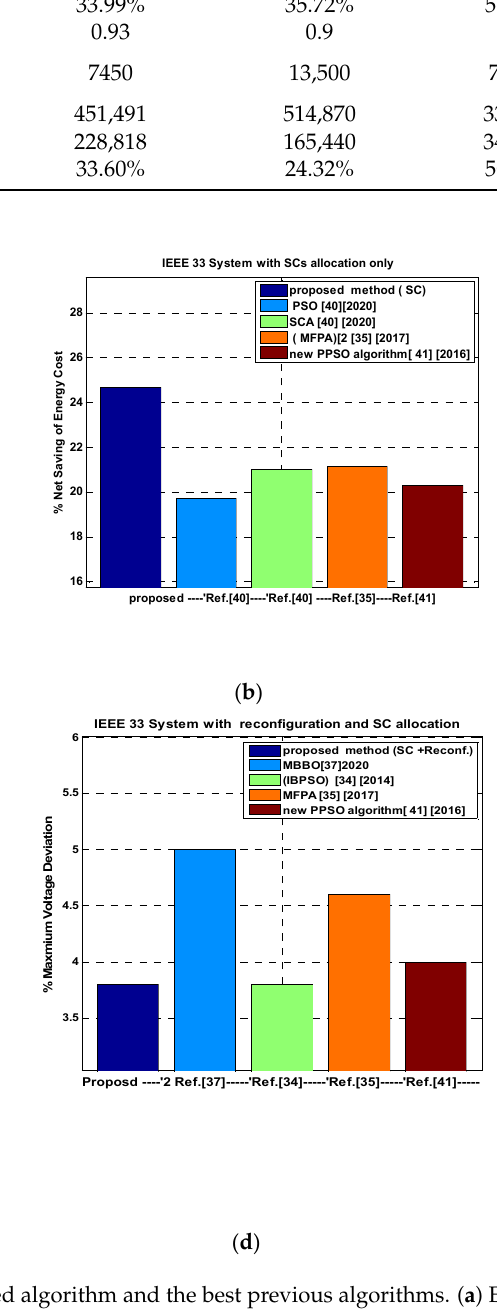
Figure 3. Comparison of the IEEE 33 system between the proposed algorithm and the best previous algorithms. ( a ) Energy- Figure 3 Comparison of the IEEE 33 system between the proposed algorithm and the 333 saving % with reconfiguration only; ( b ) energy-saving % with shunt capacitor allocation only; ( c ) energy-saving % with best previous algorithms. ( a ) Energy ‐ saving % with reconfiguration only ; ( b ) energy ‐ saving 334 shunt capacitor allocation and reconfiguration; ( d ) maximum voltage deviation % with shunt capacitor allocation only ; ( c ) energy ‐ saving % with shunt capacitor allocation and 335 reconfiguration ; ( d ) maximum voltage deviation %.